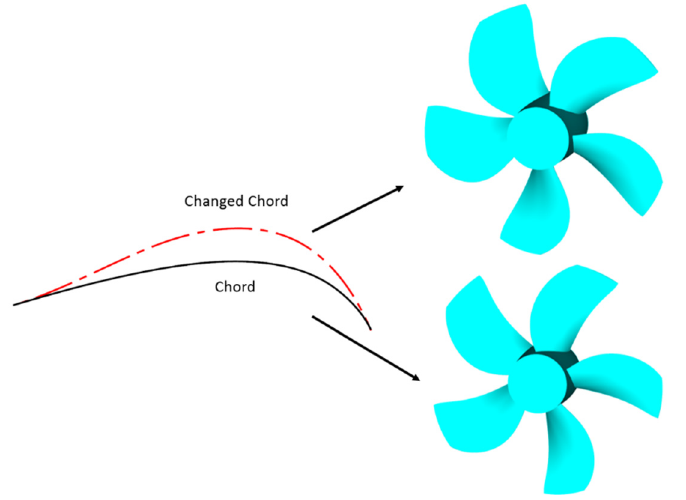
Figure 9. Schematic diagram of the mapping relationship between the chord curve and the rotor.